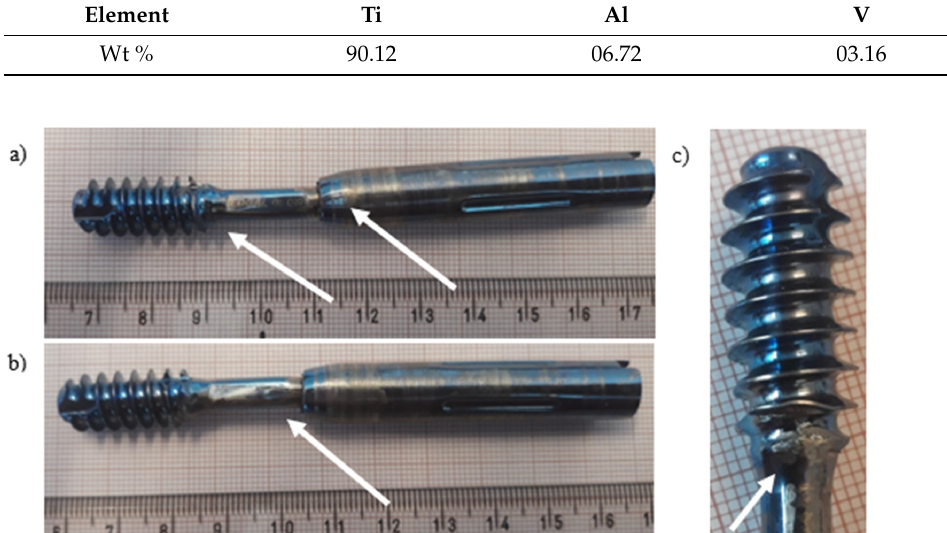
Figure 10. Visual inspection of the exploited telescopic lag screw (number 7 in Figure 9b) of the titanium implant: multiple cracks found on both sides of the telescopic lag screw ( a , b ); broken thread ( c ).